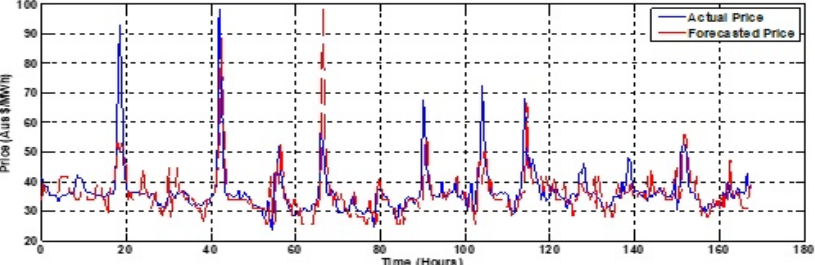
Figure 5. August 8–14, 2015 forecasting without feature selection (MAPE = 10.47).